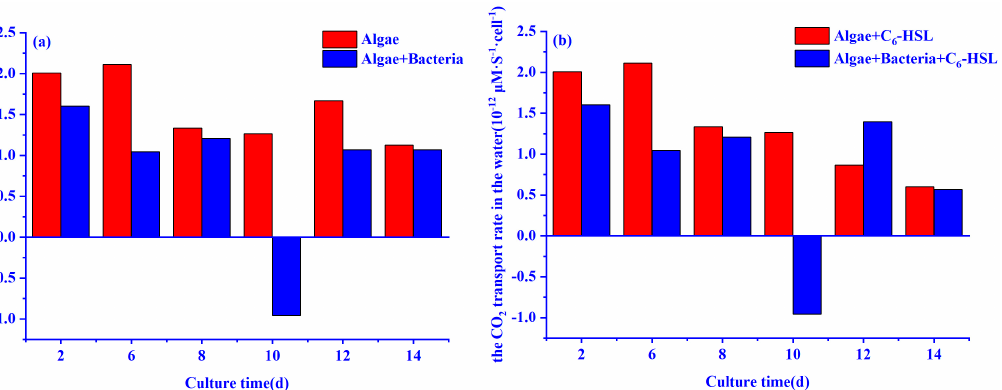
Figure 7. The CO 2 transport rate in the water of algae and algae–bacteria groups ( a ) without or ( b ) with the addition of C 6 -HSL. Algae+C 6 -HSL and algae–bacteria+C 6 -HSL are algae group and algae–bacteria group treated with C 6 -HSL, respectively.